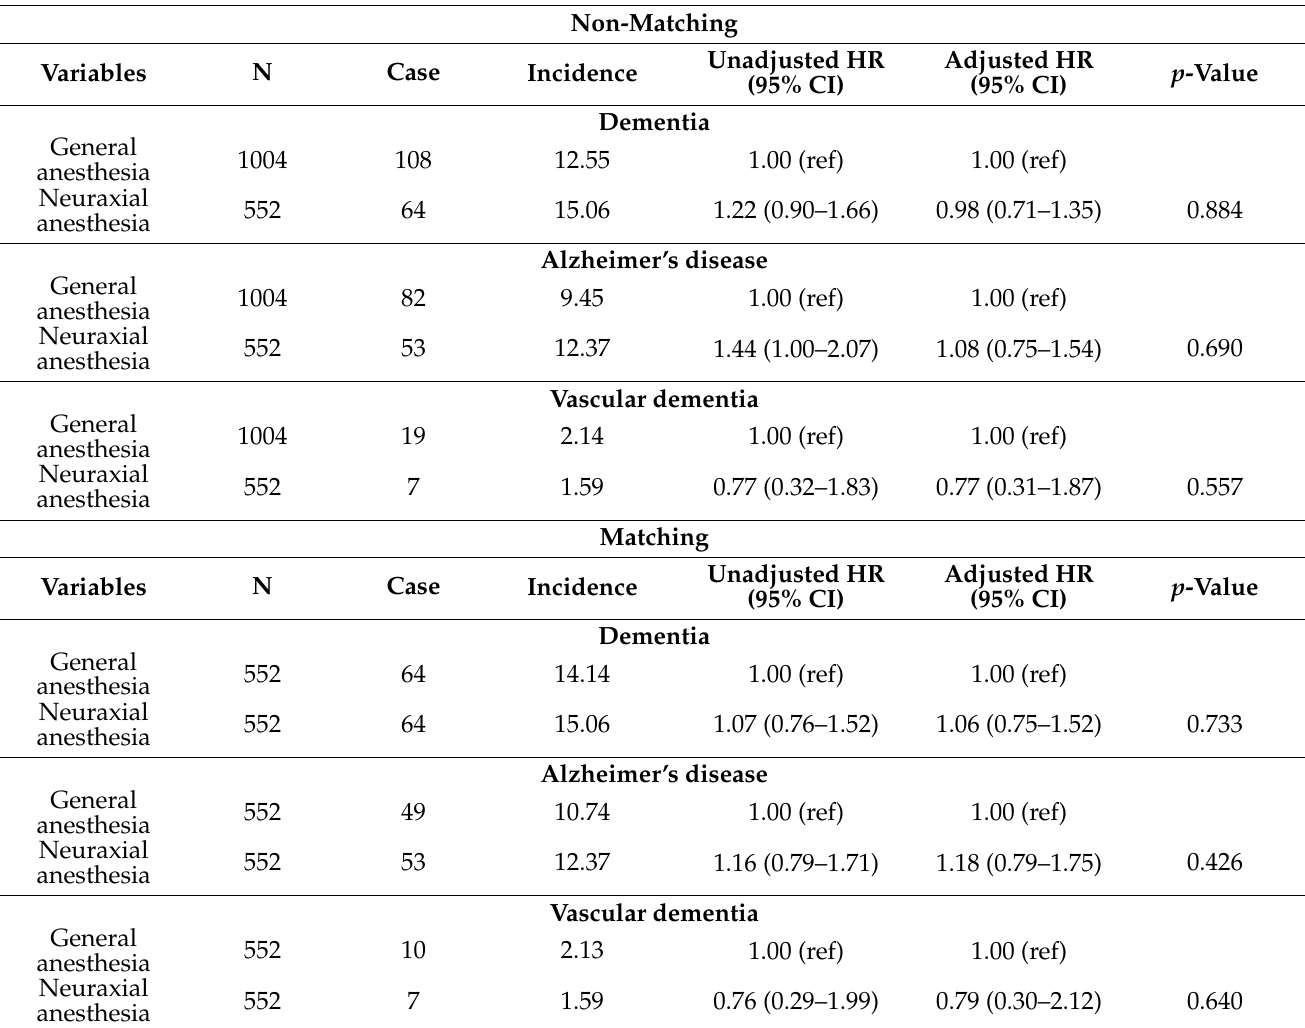
Table A6. Incidence per 1000 person-years and HR (95% CI) of dementia according to anesthesia method of musculoskeletal surgery.